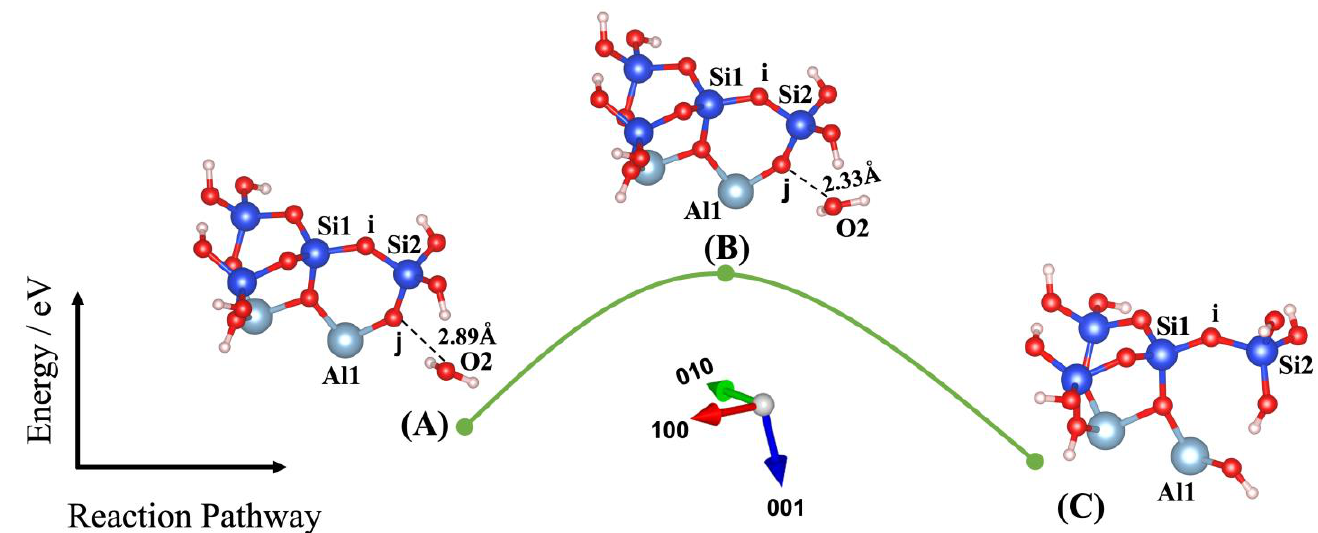
Figure 4. Model 2: ( A ) Ground state obtained as an optimized geometric structure of reactant, including water molecule as absorbent on MK surface (001) for breaking the bridging oxygen, bonded to the aluminum neighbor (Al1). ( B ) Transition state (TS) at the saddle point using improved dimer method. ( C ) Ground state obtained as an optimized geometric structure of product after protonation of the bridging oxygen, bonded to the aluminum neighbor. The structural building units are described in the caption of Figure 2. E _reactant, E _transition state, and E _product have been collected in Table 1. Table 3. The distances between the oxygen from water, Si, Al, and oxo-bridging in the transition states (B) as shown in Figures 3 – 6.